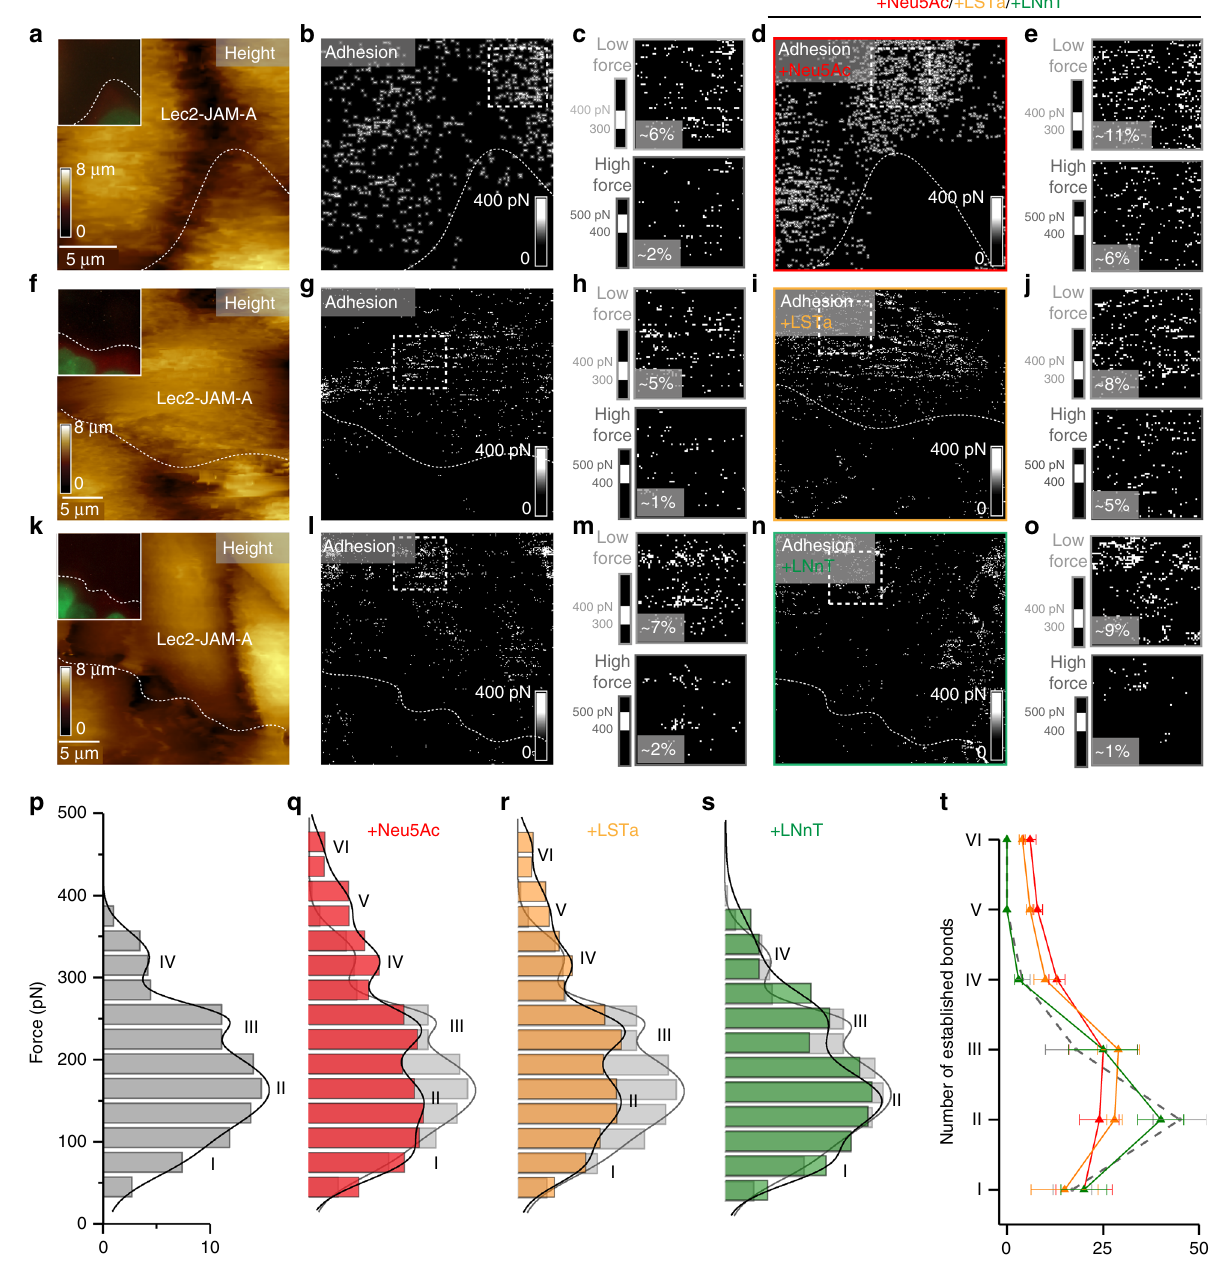
Fig. 7 Monitoring the effect of SA addition on reovirus binding to living cells. T3SA + binding to Lec2-JAM-A cells was assessed before and after adding 1 mM Neu5Ac ( a – e ), 1 mM LSTa ( f – j ), or 1 mM LNnT ( k – o ). a , f , k AFM topography image of adjacent Lec2 and Lec2-JAM-A cells with fl uorescent image (20 × 20 µ m) inset showing fl uorescently-tagged Lec2 cell lacking JAM-A expression. b , g , l Corresponding adhesion map recorded before injection of glycan. c , h , m Enlarged images of adhesion maps recorded on Lec2-JAM-A cells (dashed square in adhesion map). The upper images display the lower force range (300 to 400 pN), whereas the lower images display the higher force range (400 to 500 pN), with signi fi cantly fewer adhesion events. d , i , n Adhesion maps recorded following injection of free Neu5Ac ( d ), LSTa ( i ), or LNnT ( n ). The area probed is similar to the area recorded before glycan injection. e , j , o Enlarged images of adhesion maps recorded on Lec2-JAM-A cells (dashed square in adhesion map and similar areas as in b , g , i show more adhesion events in the high-force range upon injection of sialylated glycan [Neu5a and LSTa] and no signi fi cant change for non-sialylated glycan [LNnT]). The frequency of adhesion events is indicated. ( p – s ) Histogram of the force distribution extracted on Lec2-JAM-A cells (dashed square in adhesion map) before ( p ) and after adding Neu5Ac ( q ), LSTa ( r ), and LNnT ( s ) ( n > 700 for each condition). Histograms were fi tted with a multi-peak Gaussian distribution. t Number of bonds established between JAM-A cell-surface receptors and T3SA + before (grey dashed) and after injection of sialylated or non-sialylated glycans (colored). Error bars indicate s.d. of the mean value. The statistical analysis is shown in Supplementary Table 1. For all experiments, data are representative of at least n = 15 cells from n = 5 independent experiments. Source data are provided as a Source Data fi